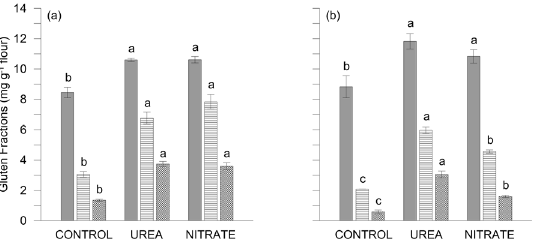
Fig 4. Gliadin and glutenin contents in in durum wheat mature grains under CONTROL and UREA and NITRATE fertilisation treatments. Gliadins (mg g -1 flour; grey chart) and glutenin (GS) fractions (mg g -1 flour; horizontallines: LMW-GS fraction; diagonal cross: HMW-GS fraction) in durum wheat grains fertilized with urea (UREA) and calcium nitrate (NITRATE) at the rate of 150 kg N ha -1 plus unfertilized CONTROL in 2011 (a) and 2012 (b). Data are averages ± standard errors, for n = 3 independent replicates. Different letters indicate significant differences at p < 0.05 (Fisher ’ s LSD test).